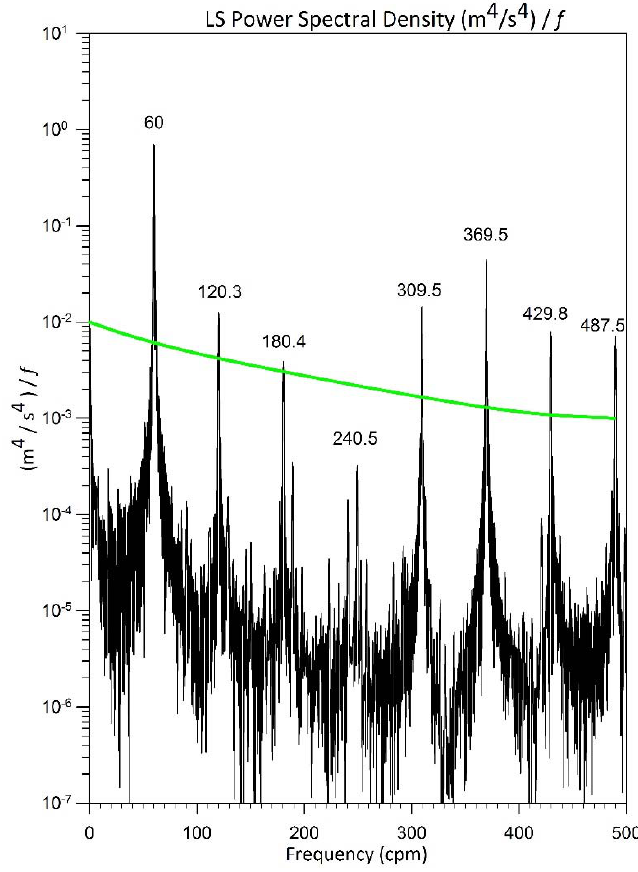
Figure 6. Least squares PSD of the deinterlaced sampled signal (disturbing potential). The modulat- ing frequency of 8.6 CPM is missing. The green line shows the 95% prediction level.